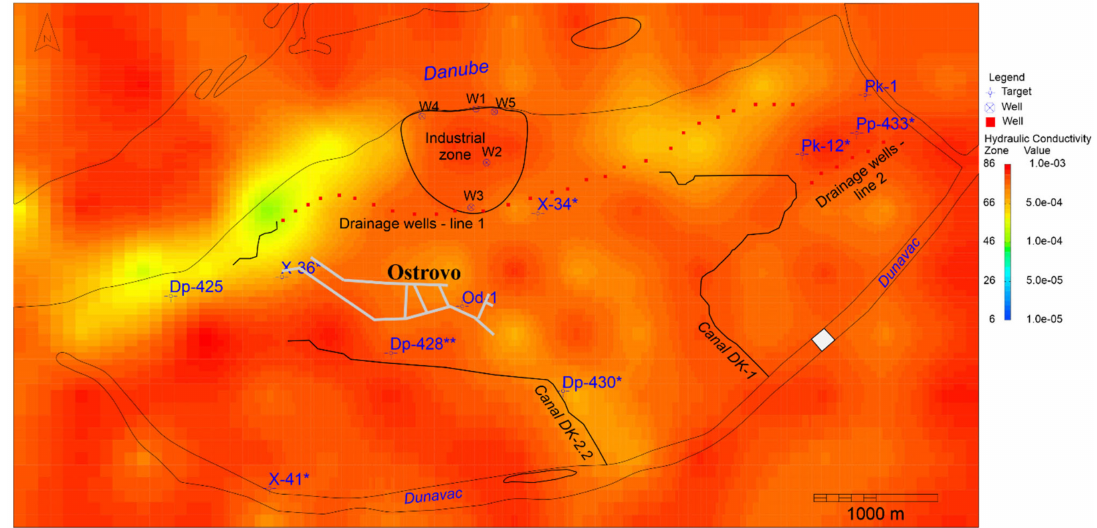
Figure 11. Zones and hydraulic conductivity K x,y matrix of the third model